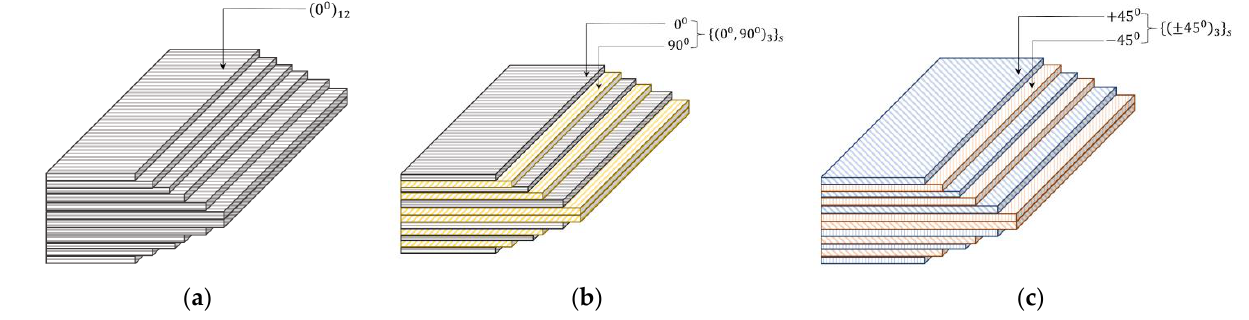
Figure 2. Illustration of laminate stacking sequence: ( a ) UD, ( b ) CP, and ( c ) AP.